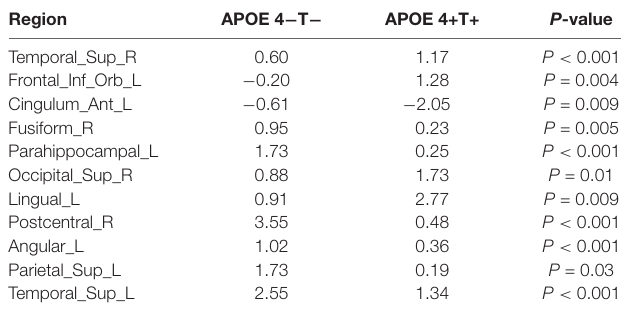
TABLE 7 | Significant differences in the degrees ( P < 0.05;